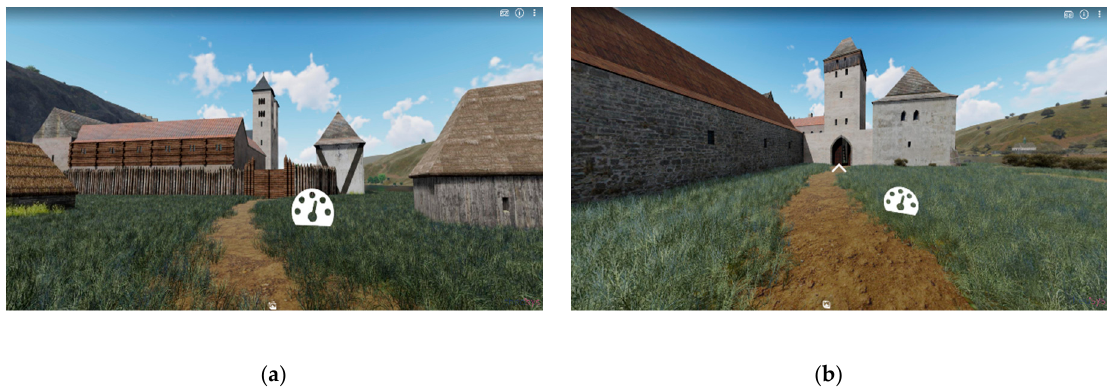
Figure 17. The navigation between historical periods ( a ) the Romanesque era view and ( b ) the Gothic era view from the same spot and with the same view frustrum.